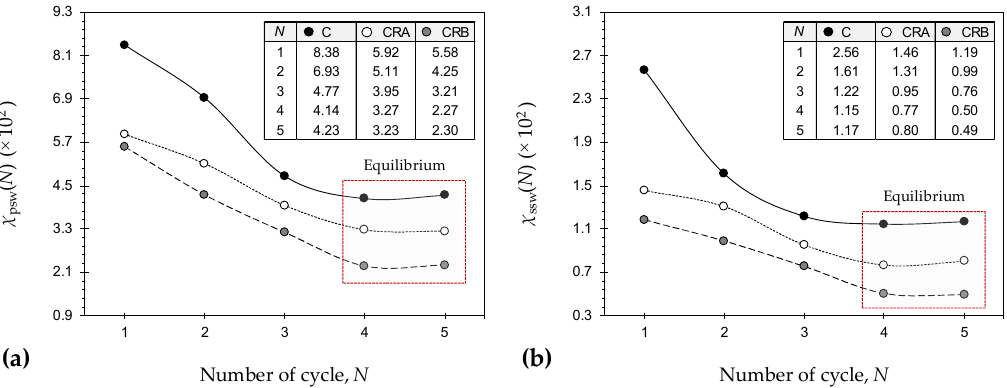
Figure 5. Rate of swelling for the tested samples during alternate wetting cycles: ( a ) primary swelling coefficient; and ( b ) secondary swelling coefficient.